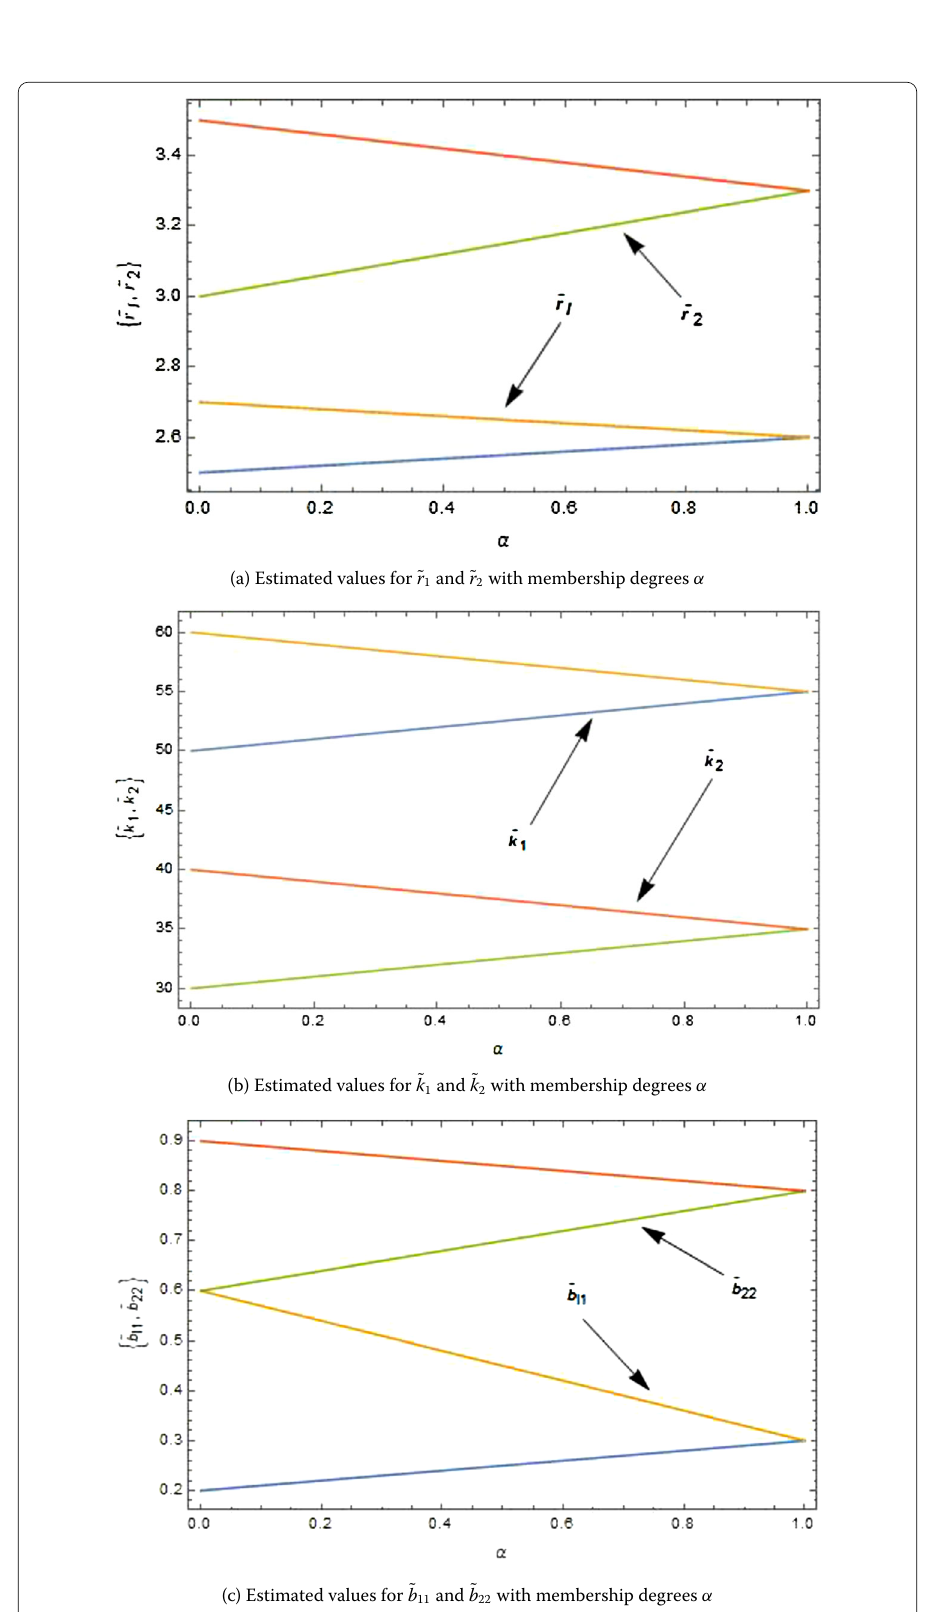
Figure 1 Triangular fuzzy structures of biological parameters for systems